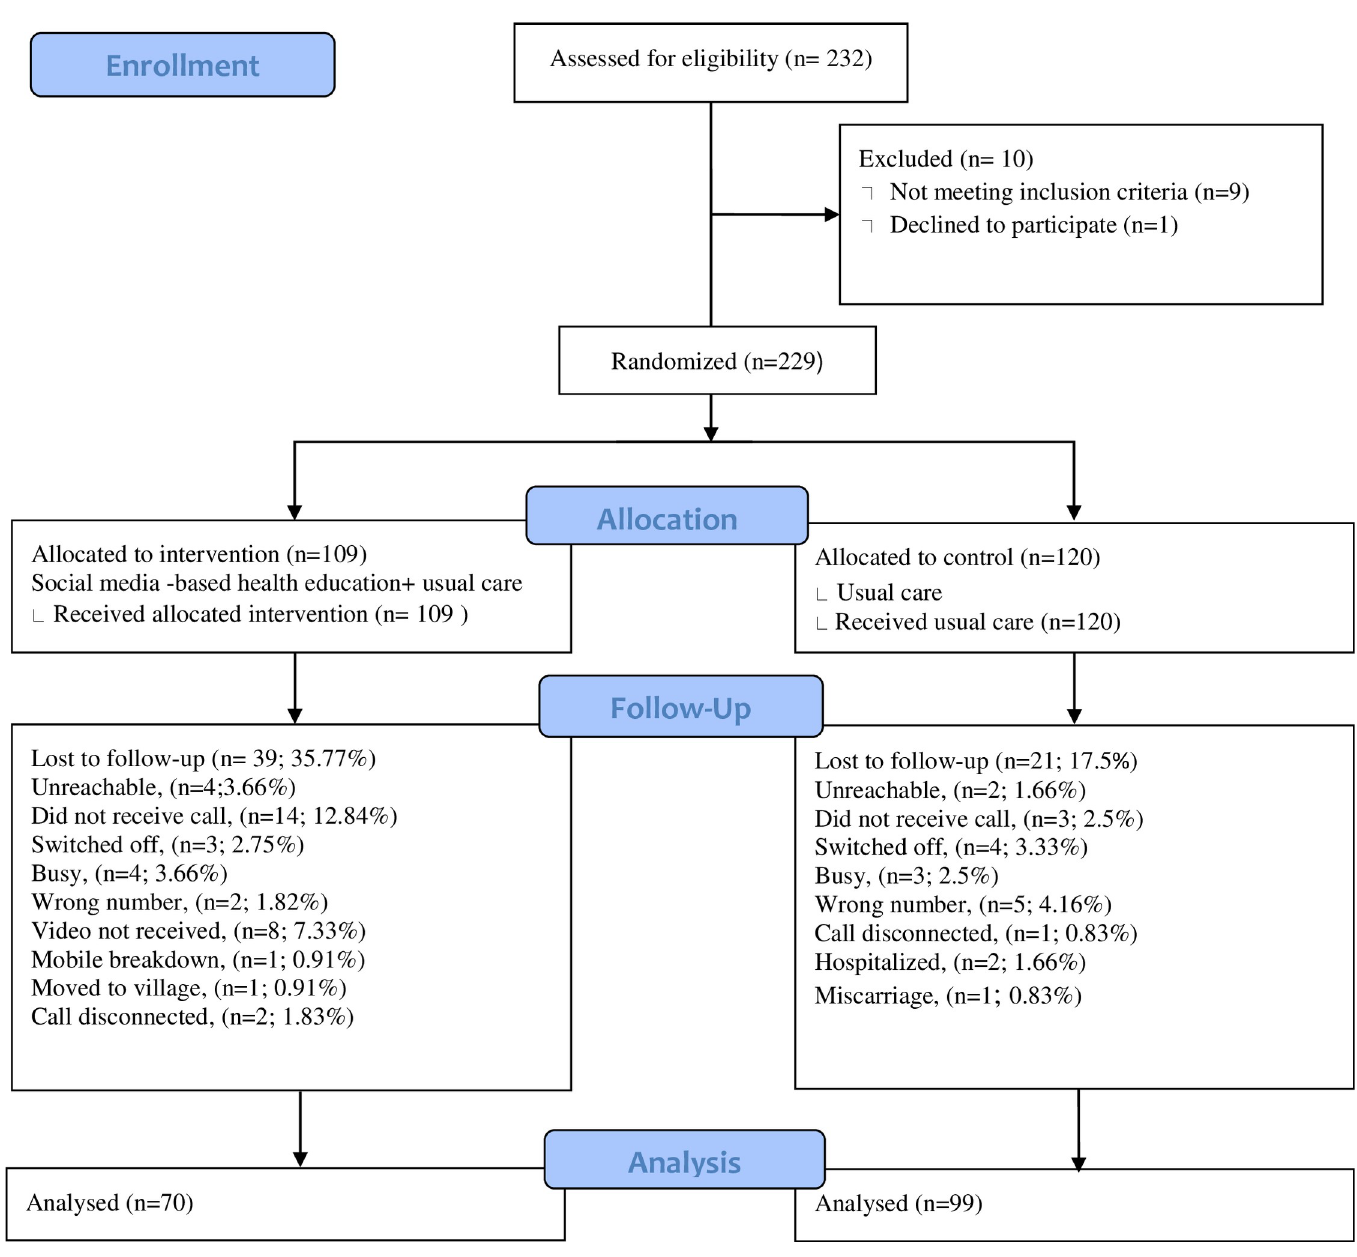
Fig 1. CONSORT flow